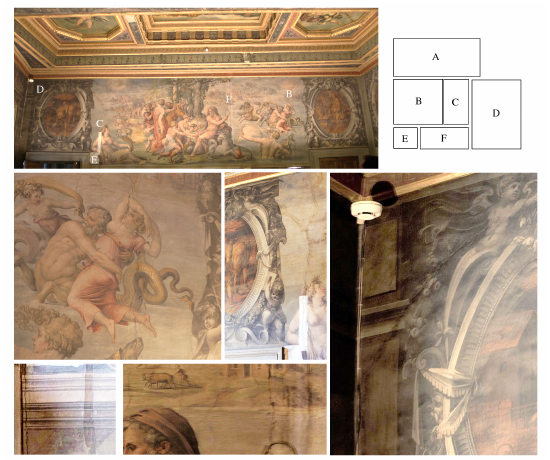
Figure 4. Cracks on fresco in the Room of the Elements in Palazzo Vecchio.